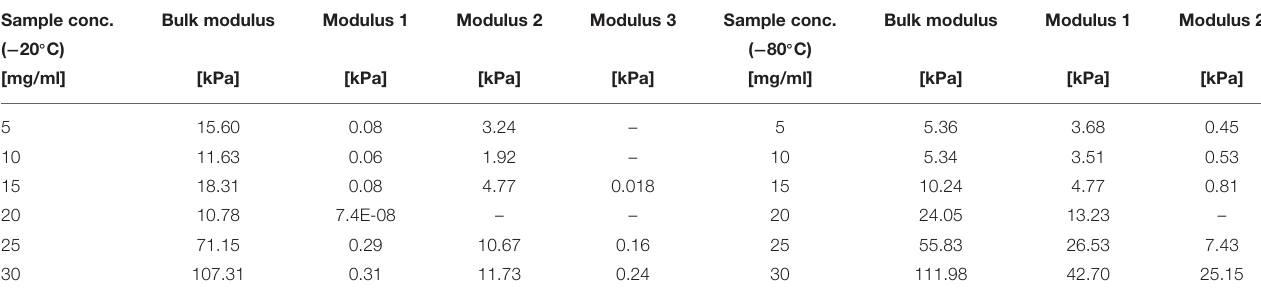
TABLE 4 | Moduli obtained from the fit of the sponge scaffold compression test. Sample conc.